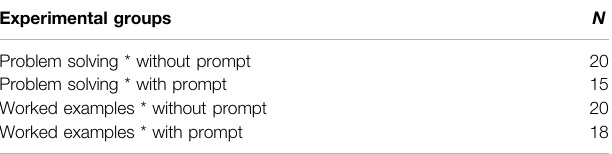
TABLE 1 | Number of participants in each experimental group of study